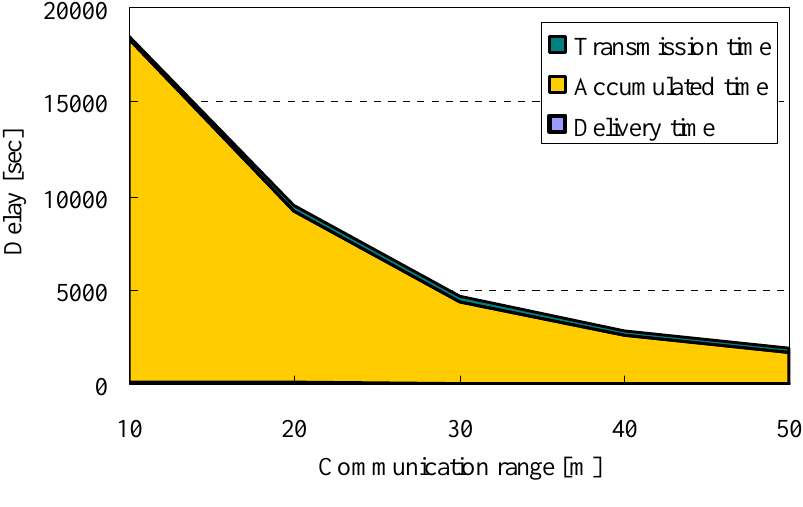
Figure 19. Communication range and details of delay in DATFM.